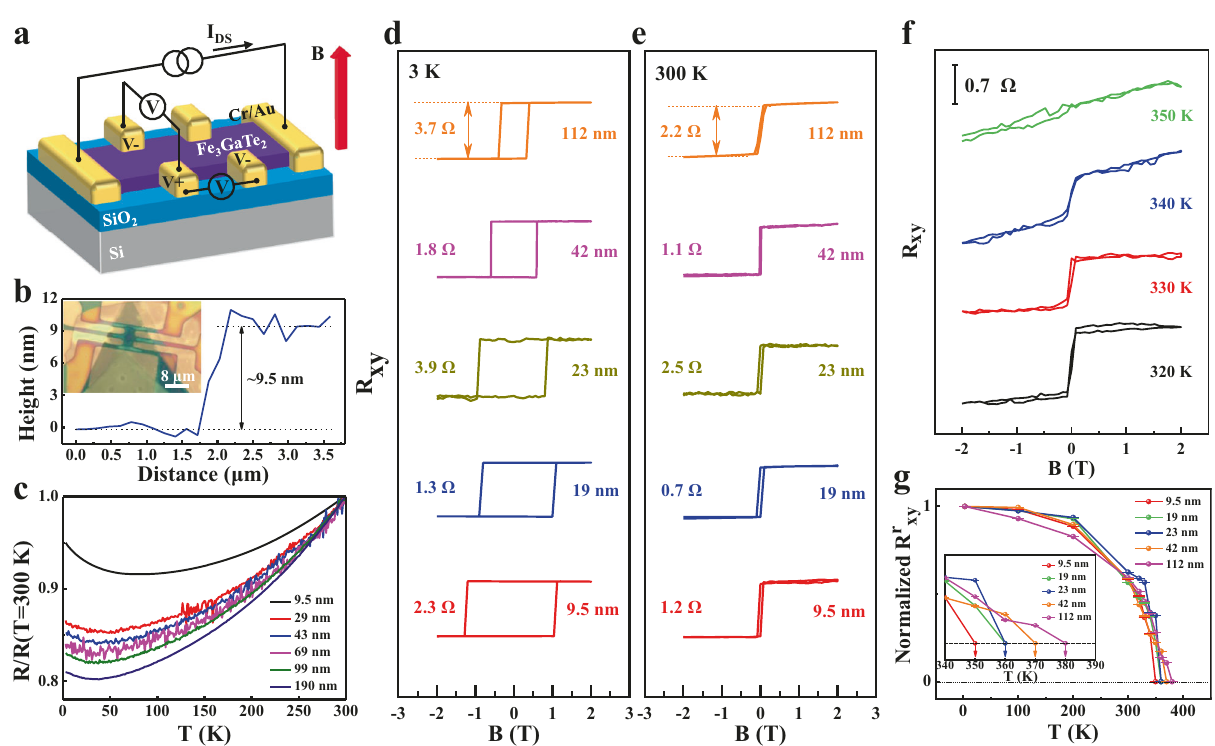
Fig. 3 | Magneto-transport measurements and thickness-dependent anom- alous Hall device performances in single-sheet Fe 3 GaTe 2 nanosheets. a Schematic and measurement geometry of the Fe 3 GaTe 2 Hall device. b Optical image and height pro fi le of the few-layer Fe 3 GaTe 2 Hall device. c Temperature- dependentlongitudinalresistanceofFe 3 GaTe 2 nanosheetswithdifferentthickness. Longitudinalresistancearenormalizedbytheirvaluesat300K.Hallresistance( R xy )